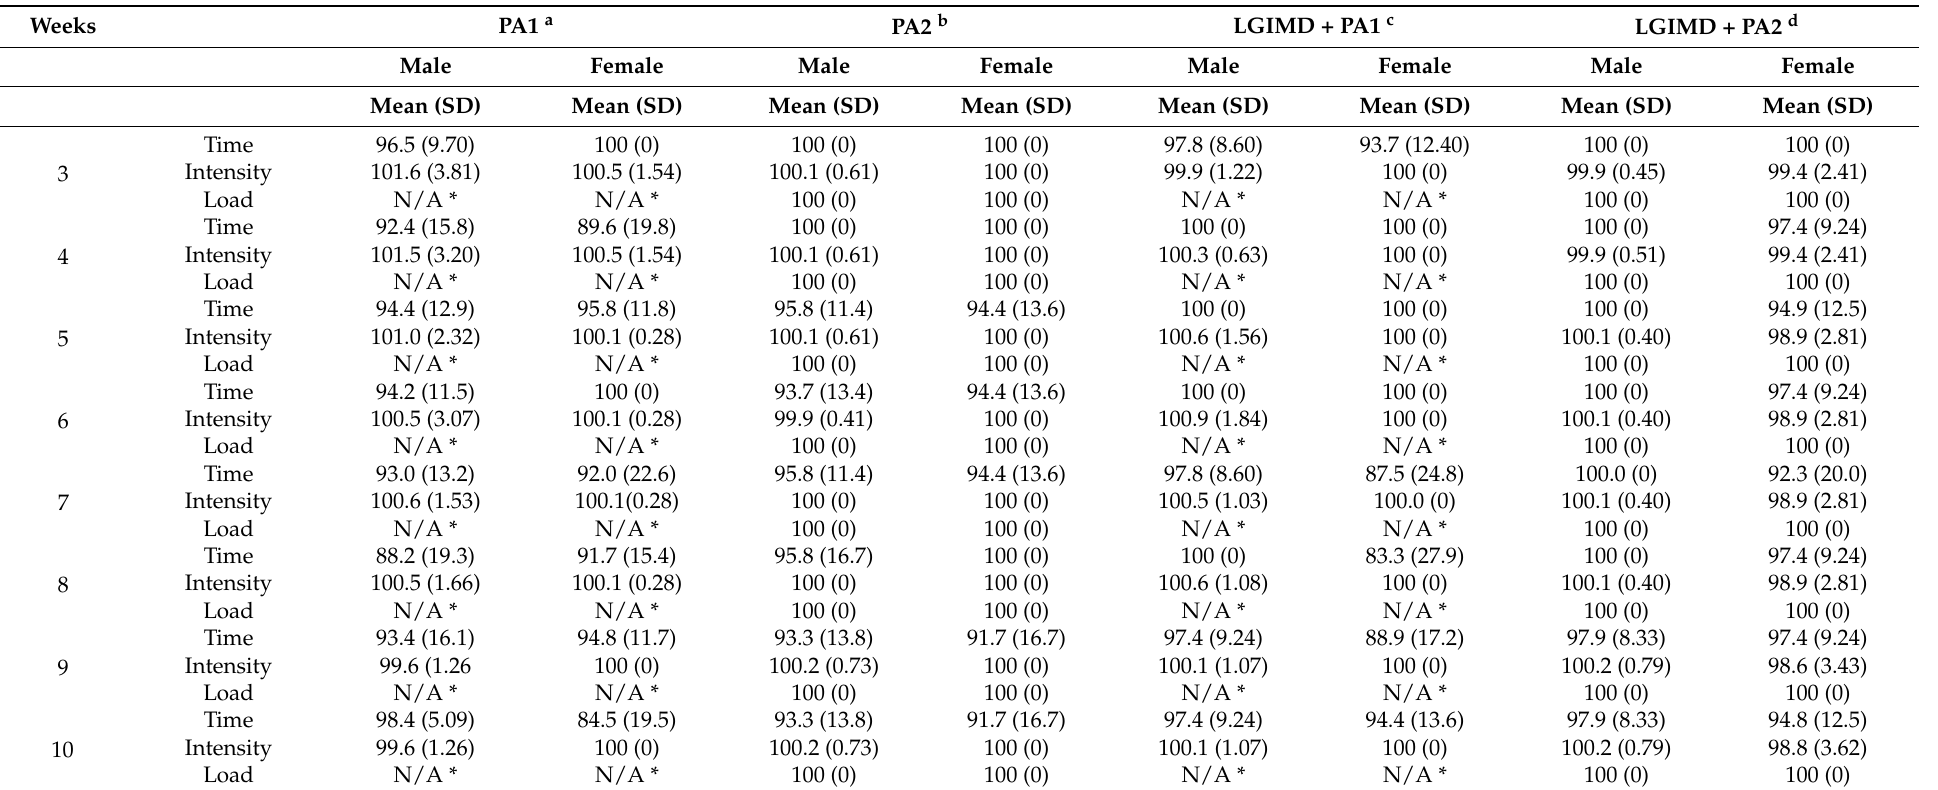
Table 4. Adherence to Physical Activity Programs by Working Arm, Gender, and Week from Enrollment. NutriAtt Trial, Castellana Grotte,